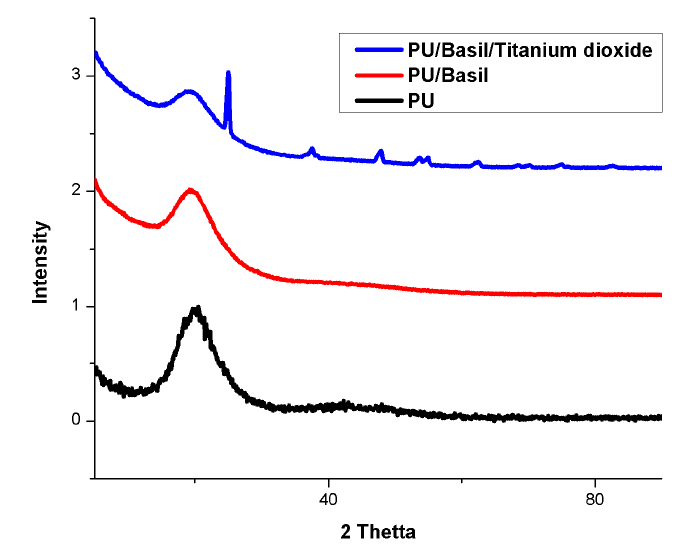
Figure 6. XRD images of PU, PU/BASIL and PU/BASIL/TiO 2 .